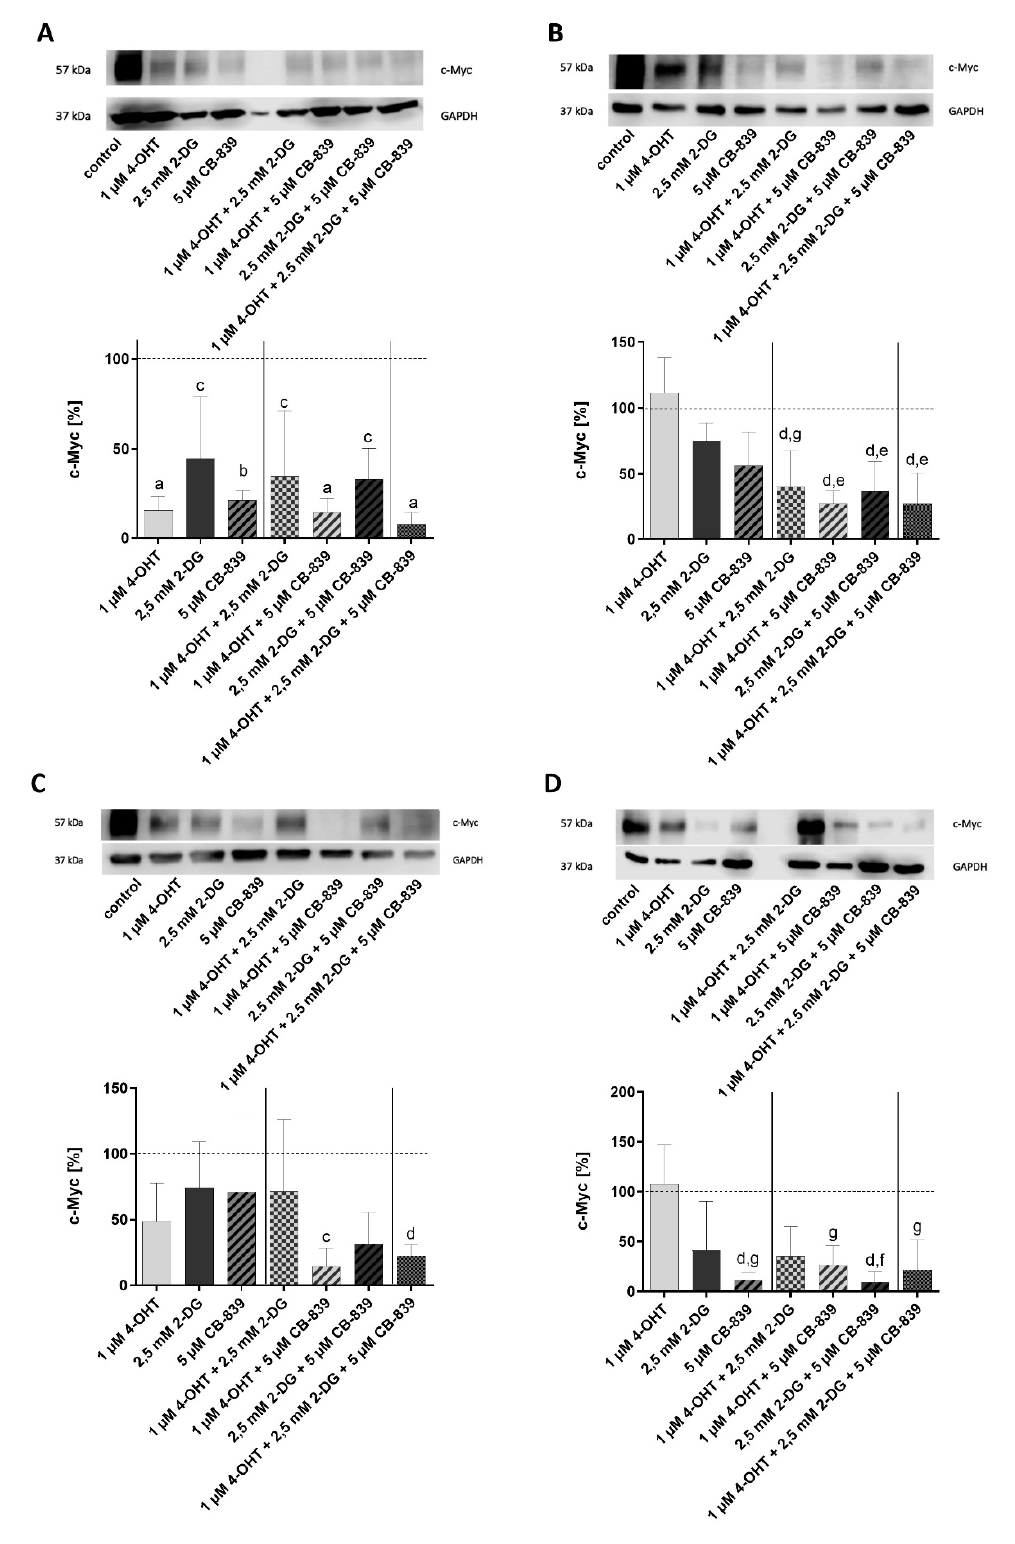
Figure 5. Protein expression of c-Myc in human breast cancer cell lines MCF7 ( A ), T47D ( C ) and their tamoxifen-resistant sublines MCF7-TR ( B ) and T47D-TR ( D ) after treatment without or with 4-OHT, 2-DG or CB-839 or different combinations. Columns represent means ± SEM of data obtained from three independent experiments in three different passages of the cell lines. a, p < 0.0001 vs. control; b, p < 0.001 vs. control; c, p < 0.01 vs. control; d, p < 0.05 vs. control; e, p < 0.001 vs. 1 μ M 4-OHT; f, p < 0.01 vs. 1 μ M 4-OHT; g, p < 0.05 vs. 1 μ M 4-OHT (ANOVA followed by Tukey’s multiple comparisons test).